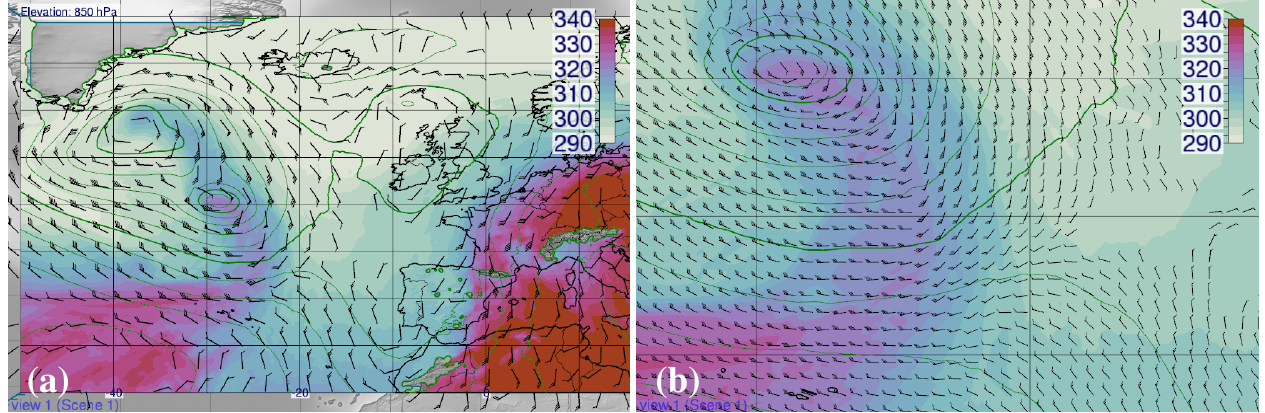
Figure 5. Met.3D automatically scales size and density of wind barbs overlain on horizontal sections. ( a and b ) Equivalent potential temper- ature (colour coded in K) at 850hPa, overlain with contour lines of geopotential height. Same forecast as in Fig. 3 (animated version of this figure in the Supplement at